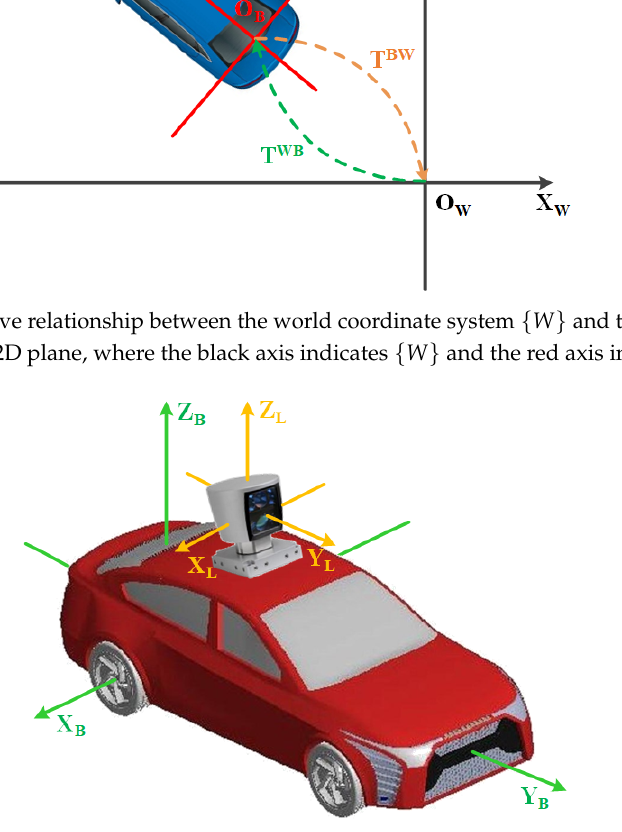
Figure 3. The relationship between the body coordinate system { L } and the lidar coordinate system { B } , where the yellow axis indicates { L } and the green axis indicates { B }